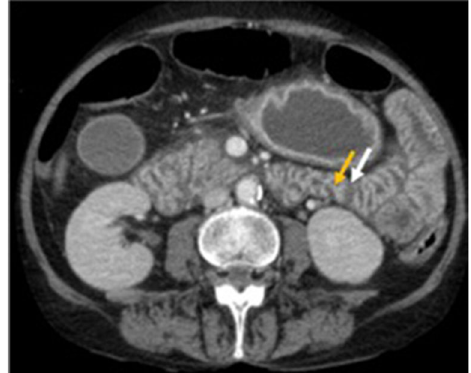
Fig. 9 Shock bowel. Contrast-enhanced axial CT images in 56-year-old male with severe head trauma and bleeding from a large scalp laceration. Findings of shock bowel include diffuse intense mucosal enhancement (orange arrow) and submucosal oedema (white arrow)